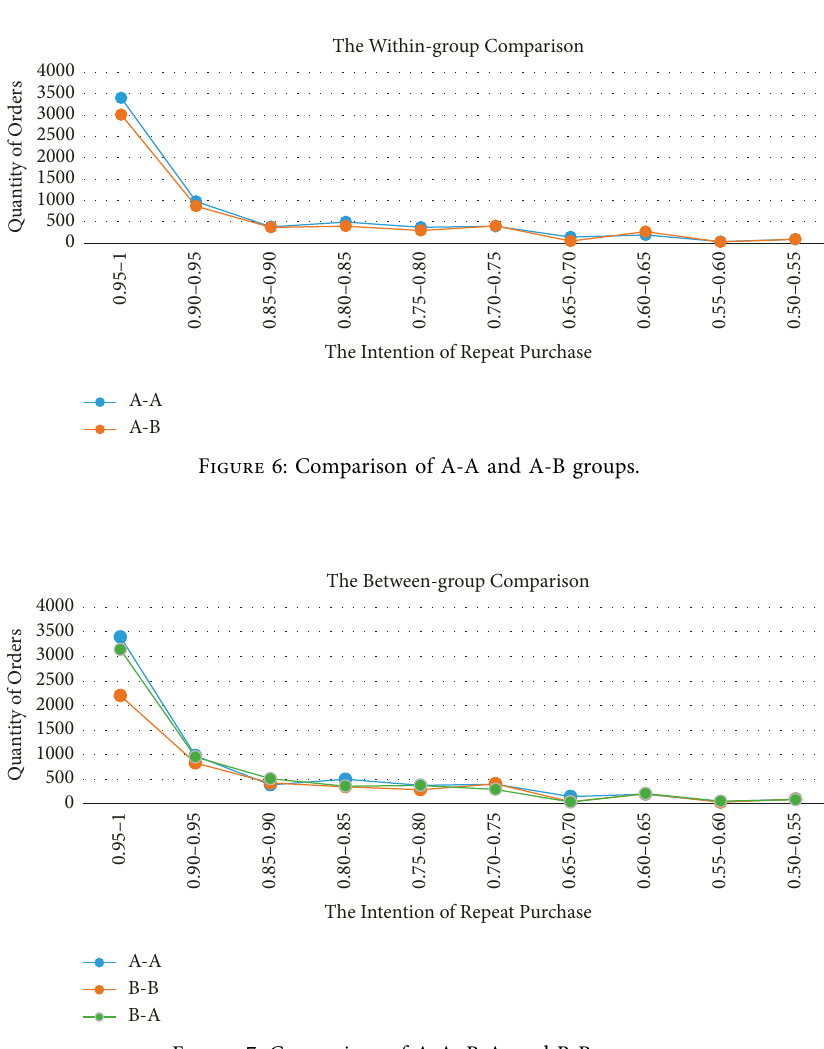
Figure 7: Comparison of A-A, B-A, and B-B groups.